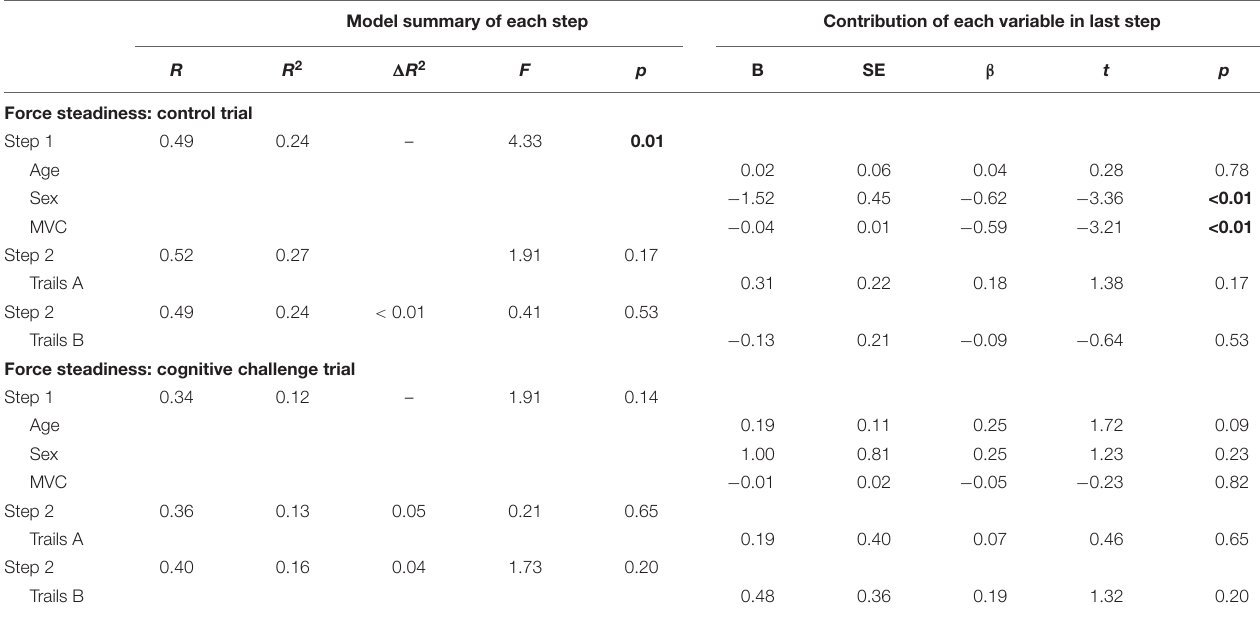
TABLE 2 | Hierarchical regression analyses predicting performance on force steadiness of young